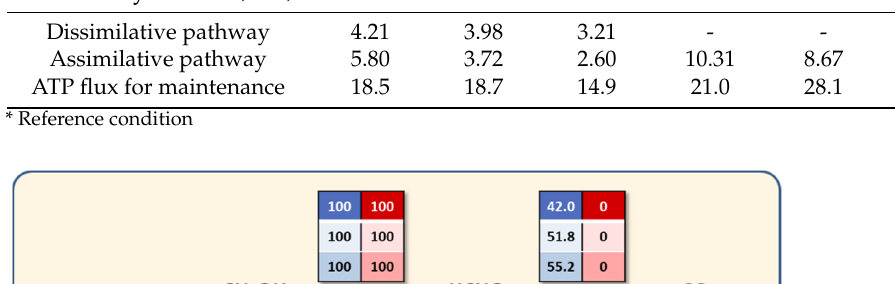
Table 3. The effect of FLD1 deletion and formaldehyde pulses on flux distribution of between assimilative and dissimilative pathways and ATP flux for maintenance (mmol/g DCW h). Control ∆ fld1